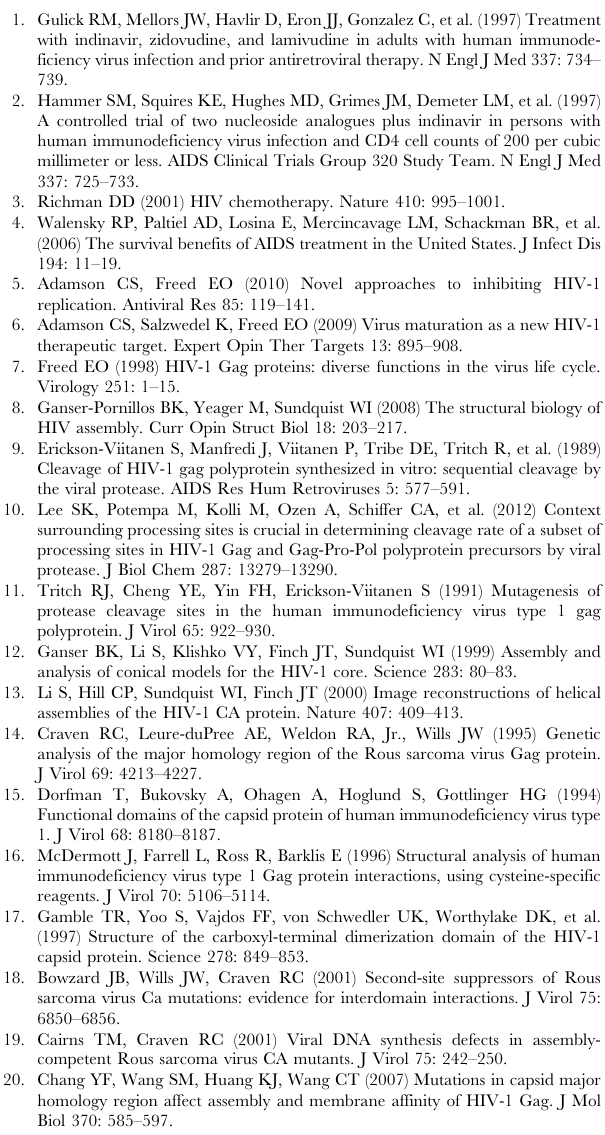
negative controls, respectively. P values: **, p , 0.01; *, p , 0.05. Note that the second-site compensatory mutation SP1-T8I rescues the multimerization defect imposed by the CA-P157S mutation. Error bars indicate SD; N=